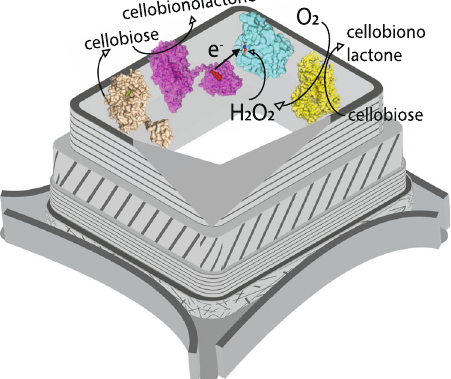
Fig.1|Schematicillustrationofthecascadereactionsoftheboundenzymeson woodcellwalls. Inthisstudy,fungalcellobiohydrolases(lightbrown,modelbased on PDB IDs: 7cel and 5x34) and Ch CDH (yellow, PDB ID: 4qi5) are used to imitate fungal H 2 O 2 production on poplar wood cell walls. The H 2 O 2 is consumed by Nc LPMO9C (cyan, PDB ID: 4d7u) after priming by its auxiliary electron donor Nc CDH (magenta, PDB ID: 4qi7). Oxygen is provided from